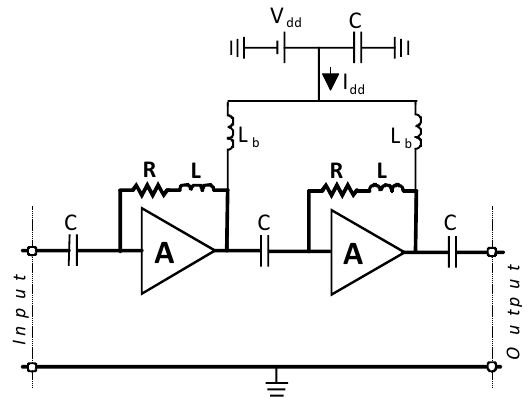
Figure 2: Prototype of two-stage NGD circuit for testing the time advance.